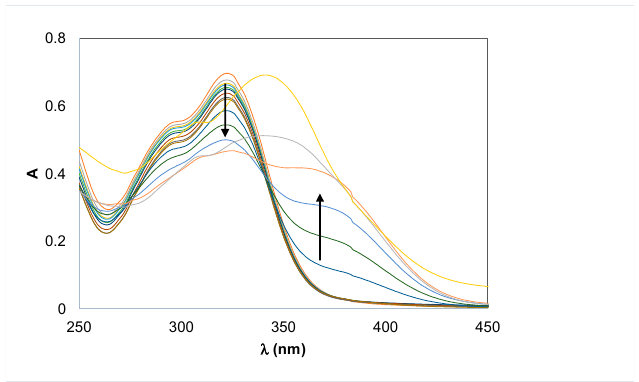
Figure 5. Spectrophotometric absorption spectra of the system Fe 3+ / 1d 1:3 (2.59 < pH < 10.22) (C L = 4.0 × 10 − 5 M, 20% DMSO/water).